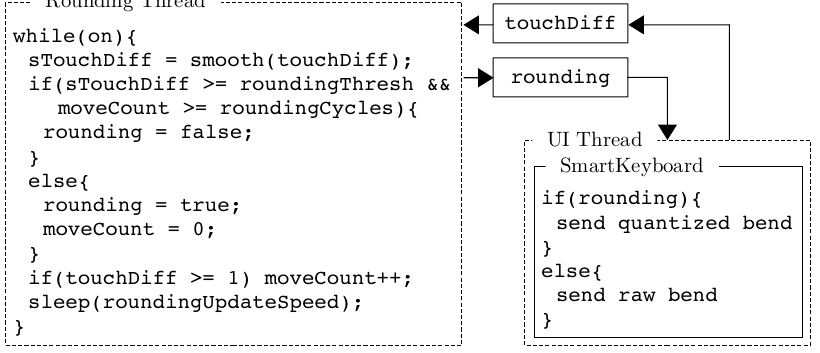
Figure 3. S MART K EYBOARD pitch rounding “pseudo code”